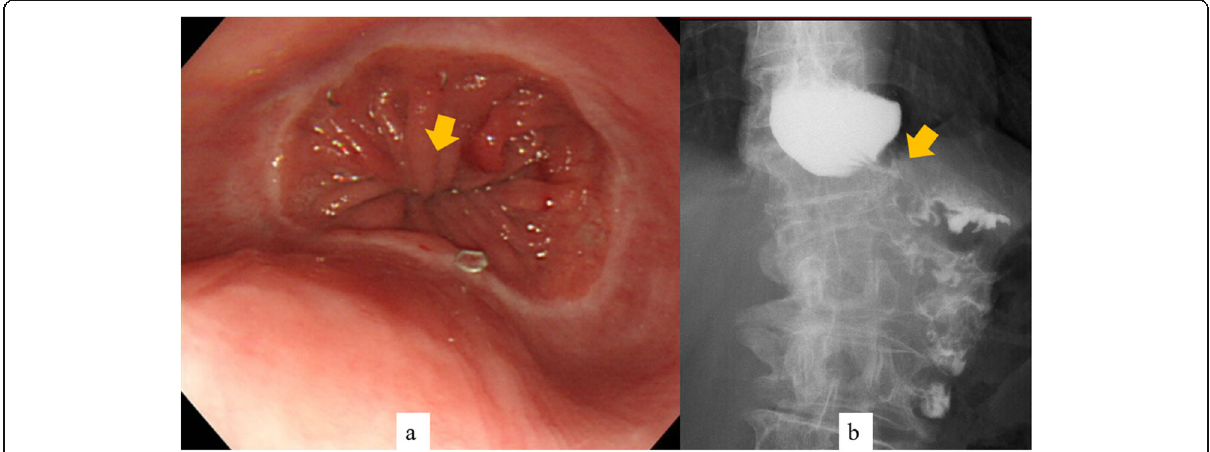
Fig. 1 Circumferential membranous stenosis of the jejunum 3 cm distal to the esophago-jejunal anastomosis. a Stenosis observed by esophagogastroduodenoscopy (arrow). b Stenosis observed by upper gastrointestinal fluoroscopy